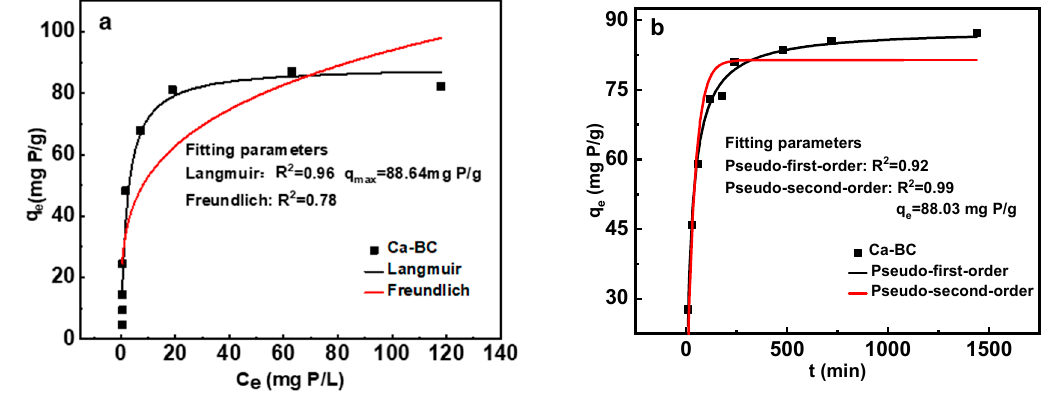
Figure 1. The adsorption isotherm of Ca-BC ( a ). (Dosage: 0.05 g; Temperature: 25 °C; Time: 24 h; pH = 7); The adsorption kinetics of phosphate onto Ca-BC ( b ). (Dosage: 0.05 g; Temperature: 25 °C; Initial phosphorus. Table 1. Fitting parameters of the phosphorus adsorption isotherms and adsorption kinetics of Ca-BC.